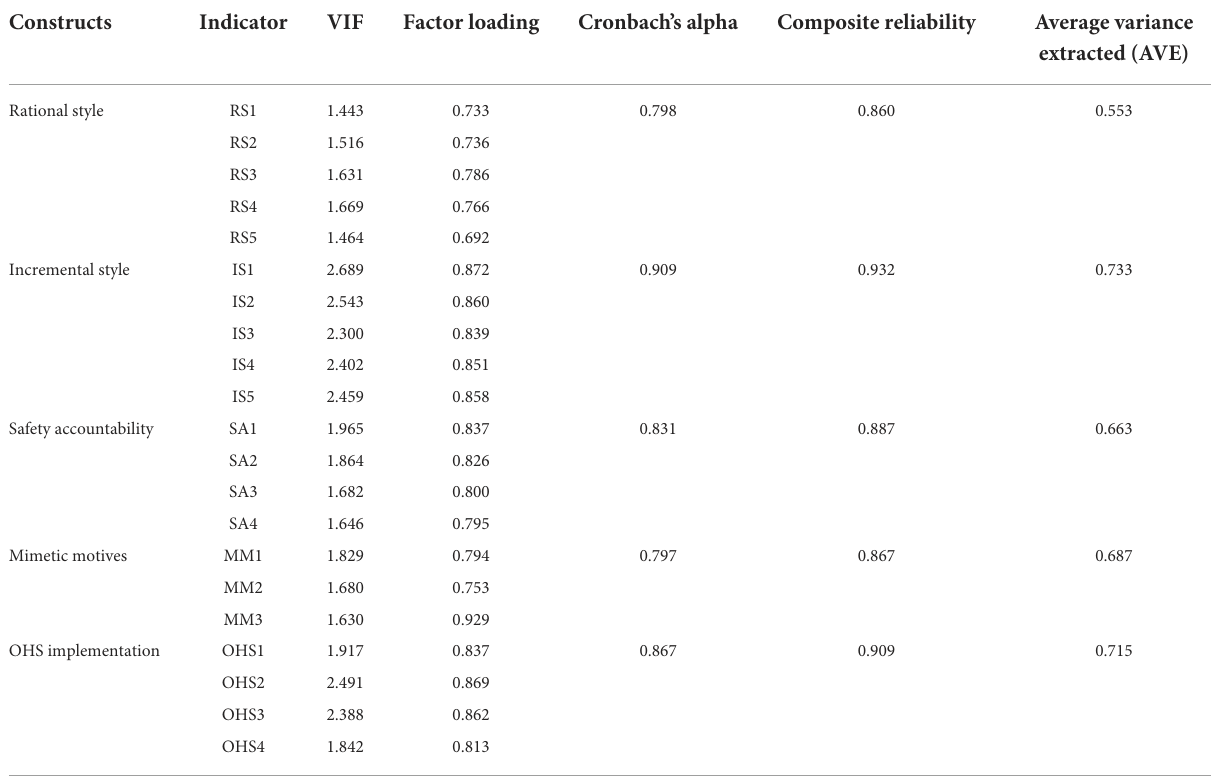
TABLE 2 Measurement model: VIF, internal consistency reliability and convergent validity.